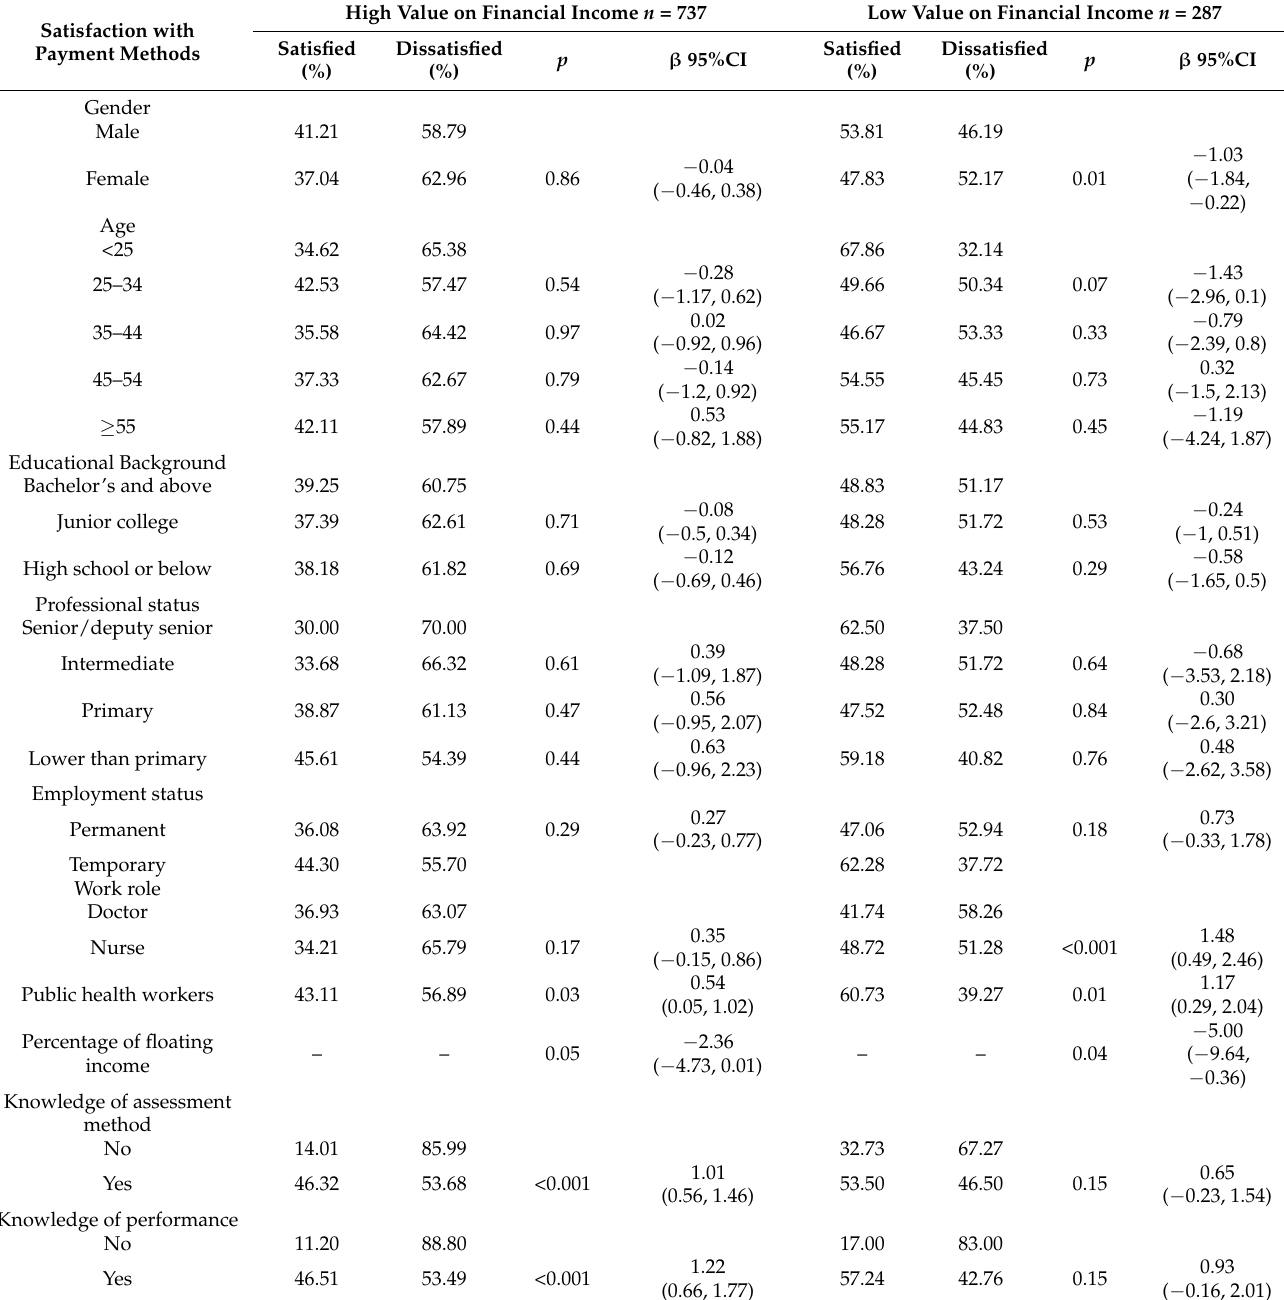
Table 3. The association between PBS design and satisfaction on payment methods for health workers with different value on financial income. Satisfaction with Payment